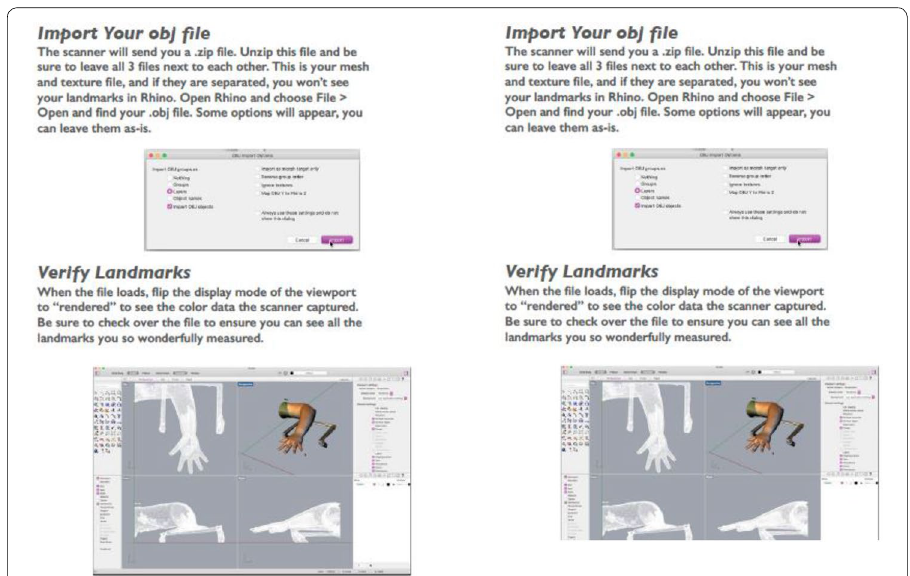
Fig. 4 Example of 3D hand scan processing in Rhino software and Stand Development (Sokolowski and Corr 2018)